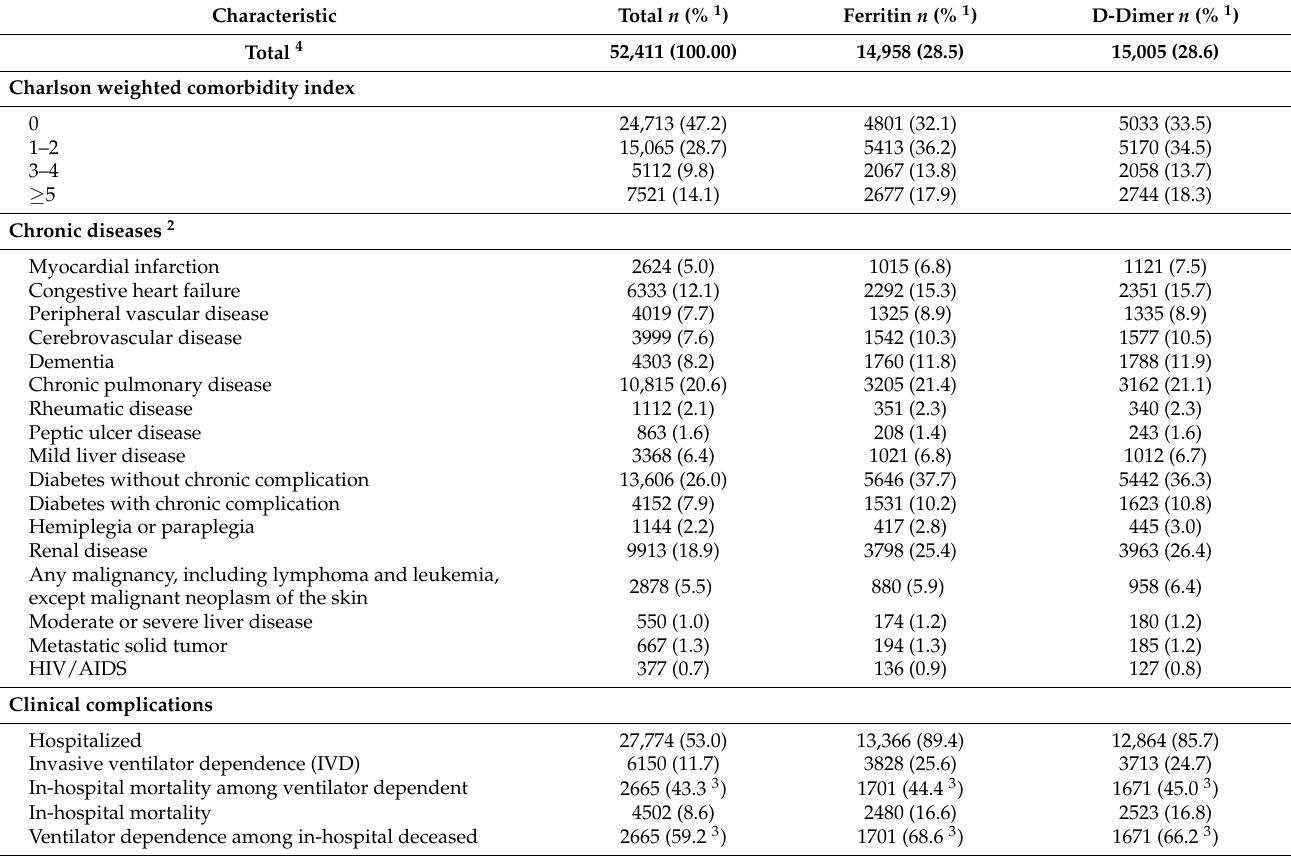
Table 1. Clinical characteristics among COVID-19 patients with valid ferritin and D-dimer laboratory measurements.